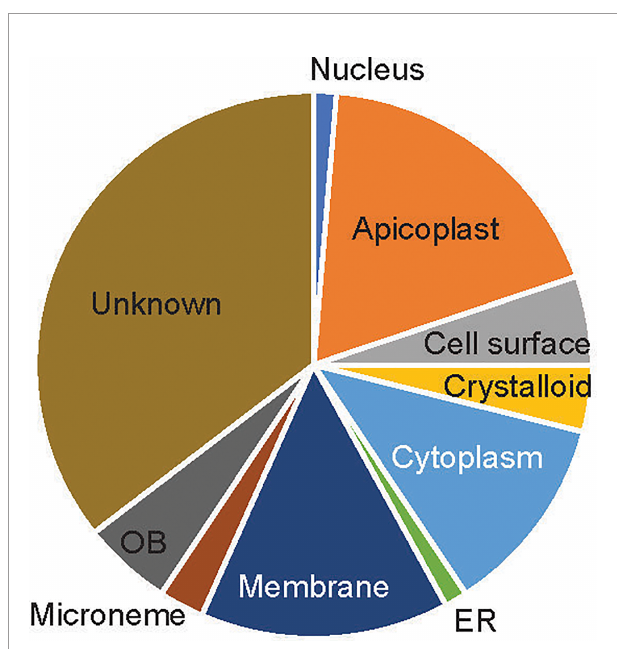
FIGURE 2 | The subcellular location of the candidate proteins. ER, endoplasmic reticulum; OB, osmiophilic